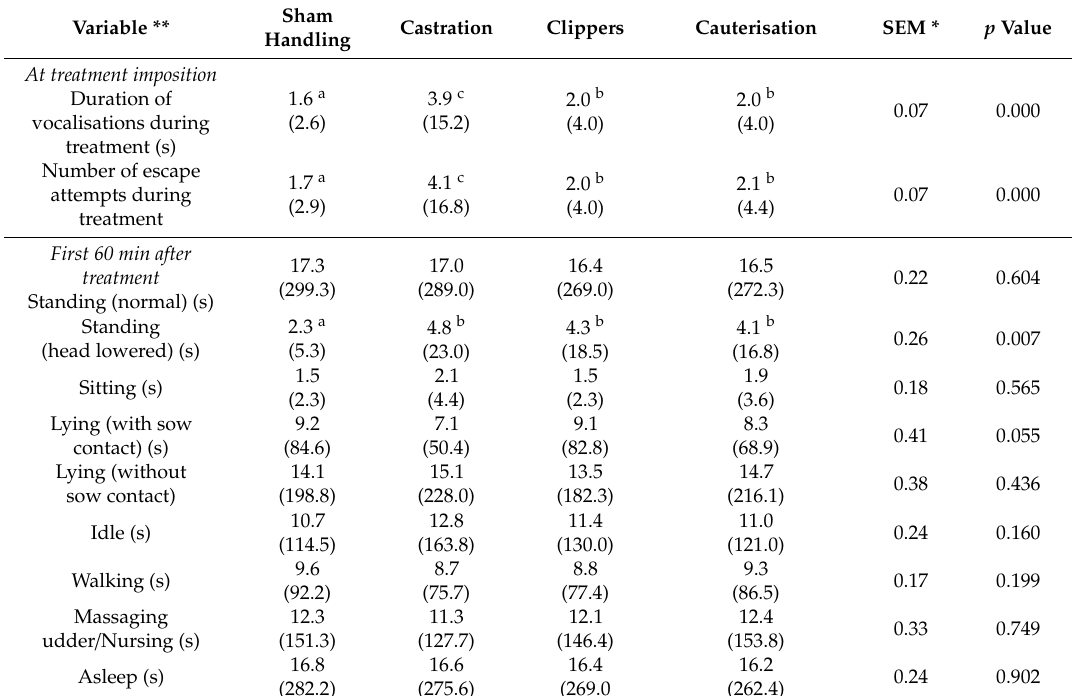
Table 3. E ff ect of treatments on duration of vocalisations and number of escape attempts during imposition of treatments and durations of behaviours of piglets for the first 60 min after treatment. Variable **